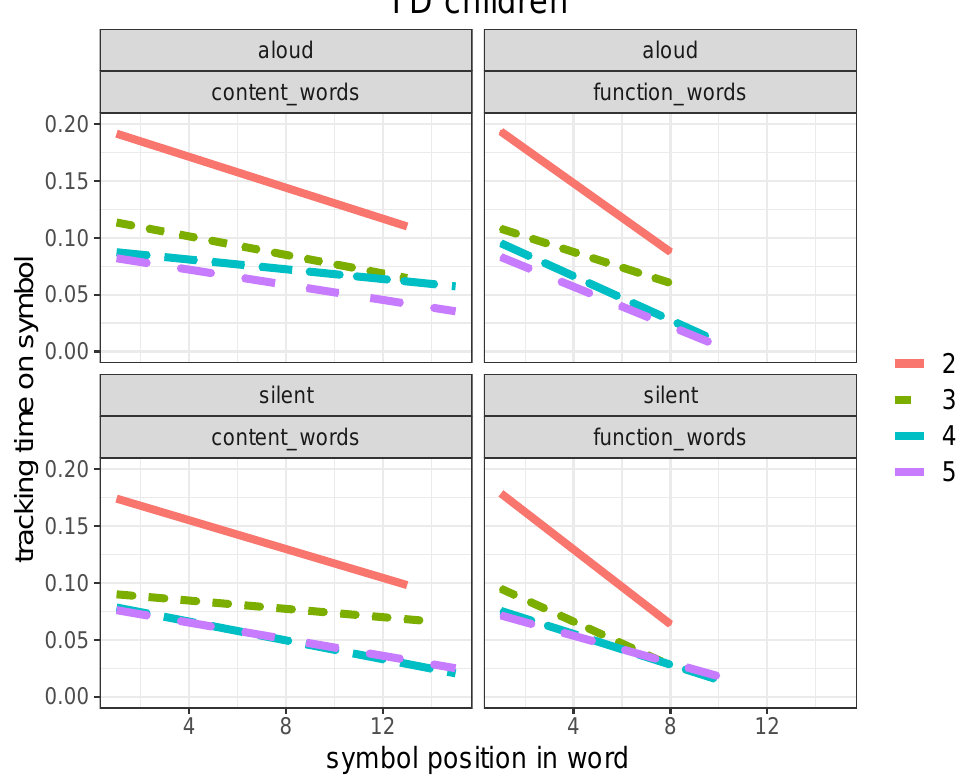
Figure 6. Linear regression plot for symbol tracking time (in seconds) as a function of their position within the word (with word onset for x = 1), for aloud ( top ) and silent ( bottom ) reading in TD children for the four grade levels (from 2nd to 5th) for content ( left ) versus function ( right ) words (plot obtained with the ggplot2 package, function lm